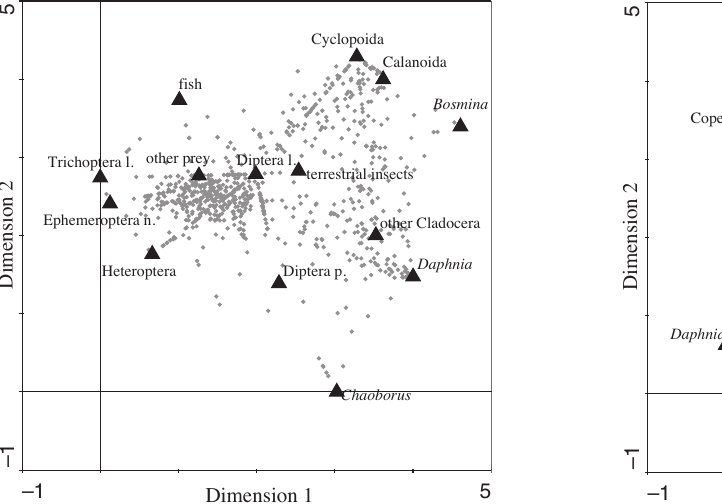
Fig. 2. Correspondence analysis biplot for the stomach Fig. 3. Correspondence analysis biplot for the stomach